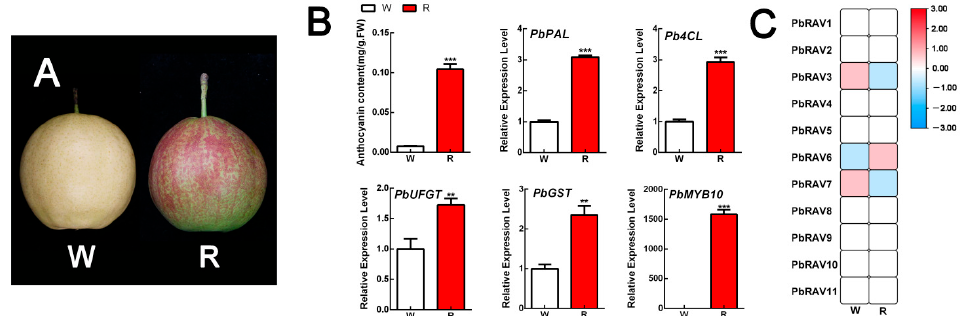
Figure 7. Expression profile of PbRAV s in red pear peel. ( A ) Appearance of ‘Xinqihong’ pear after bagging. ( B ) Anthocyanin content and expression of genes regulating anthocyanin biosynthesis. ( C ) Expression profile of PbRAV s in white and red pear peel. ** p < 0.01, *** p < 0.001 (Student’s t test). R: red pear peel; W: white pear peel. The expression levels of genes in the peel of white pear under control conditions were normalized as 1.0.